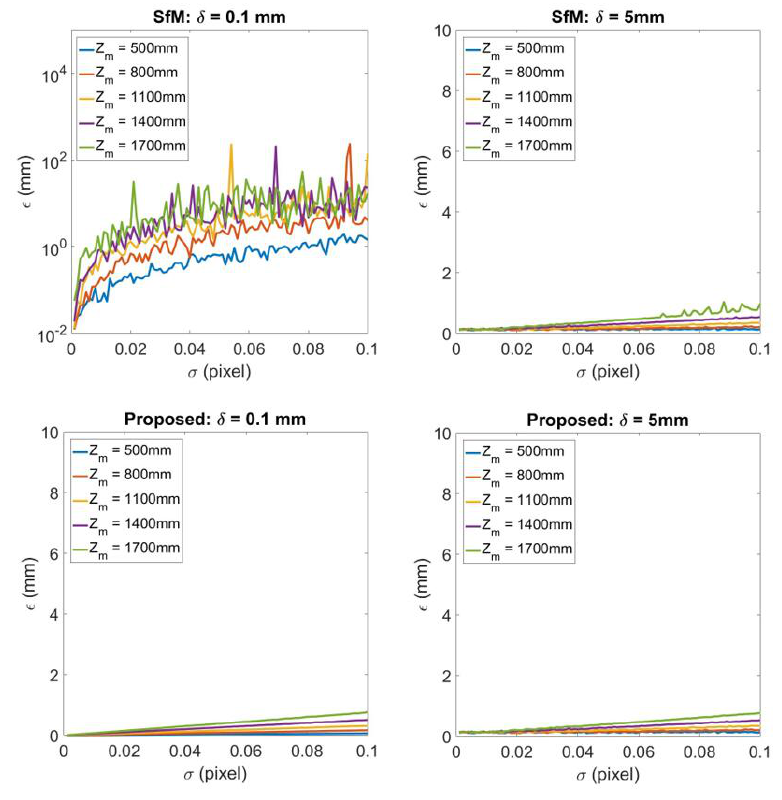
Figure 7. 3D reconstruction error for different image noise σ = 0.001,0.002, . . . ,0.1. From left to right each column represents the results for road unevenness δ = 0.1 and δ = 5 respectively. For